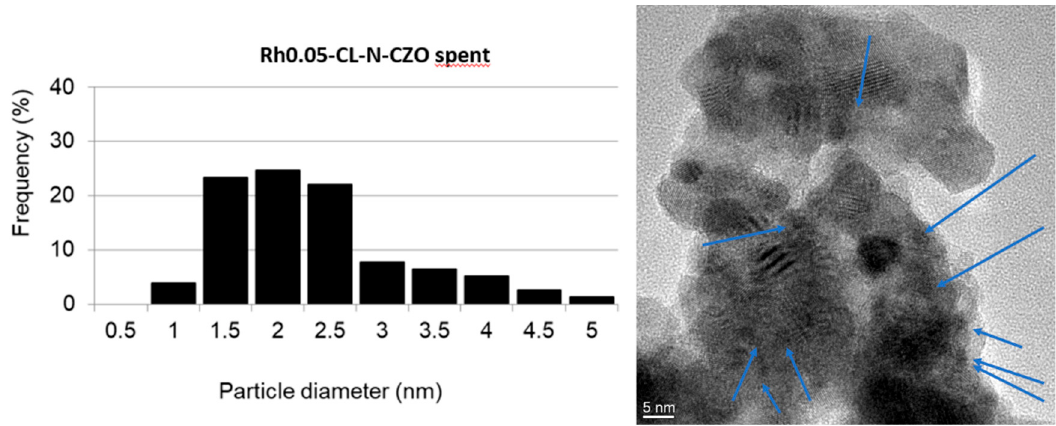
Figure 18. Particle size distribution of the spent Rh0.05-CL-N-CZOm determined via TEM analysis.